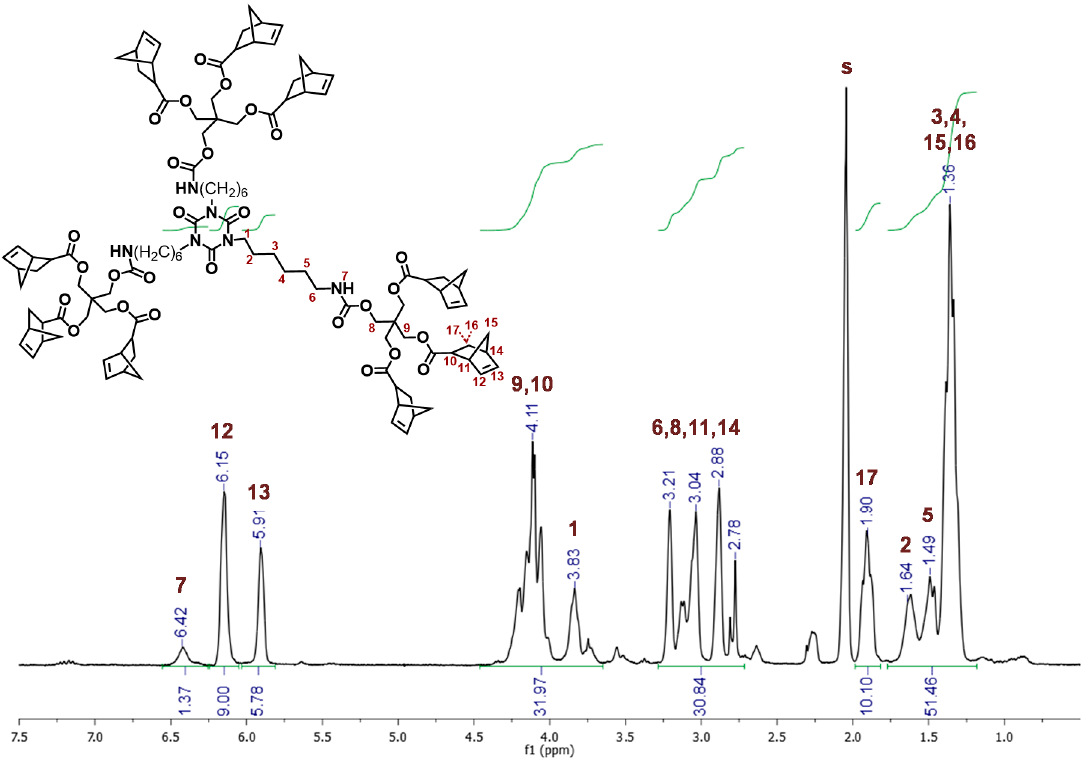
Figure 5. 1 H-NMR spectrum of aL-9-NBE in acetone-d 6 .